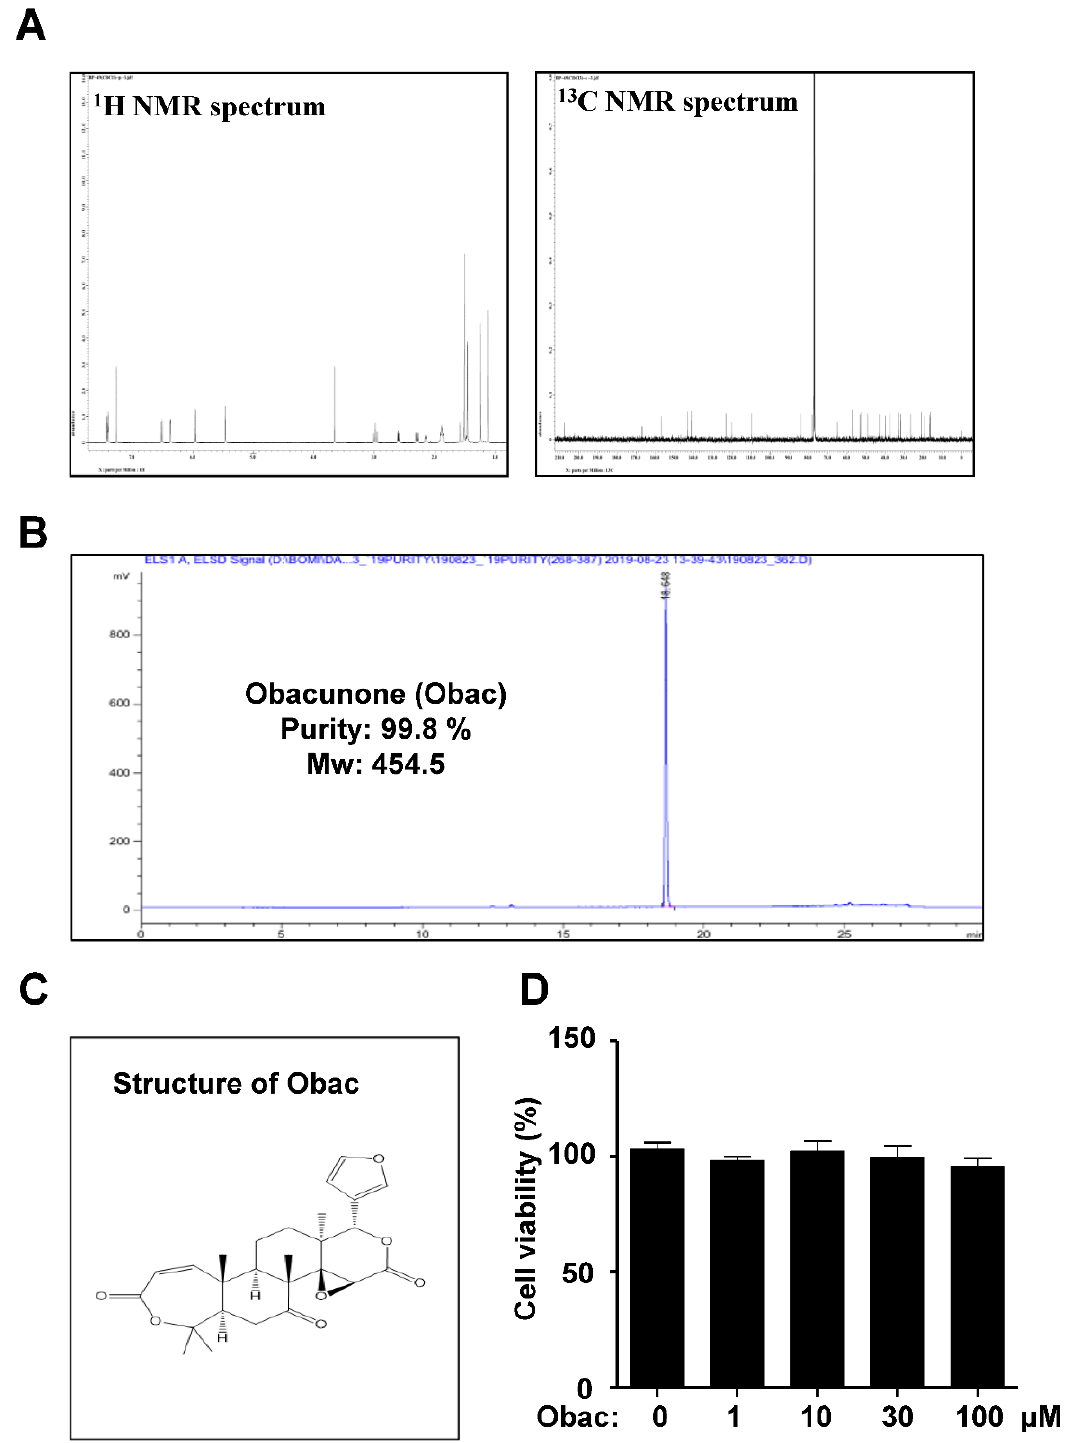
Figure 1. Effects of Obac on proliferation in MC3T3-E1. ( A ) 1 H and 13 C NMR spectra of Obac from the dried root bark of Dictamnus dasycarpus Turcz. ( B ) HPLC chromatogram of Obac. ( C ) Chemical structure of Obac. ( D ) MC3T3-E1 was incubated with Obac at concentrations of 1, 10, 30, and 100 µ M for 24 h, and cell viability was measured by the MTT assay. Data are representative of three independent experiments, and values are expressed in the mean ± S.E.M